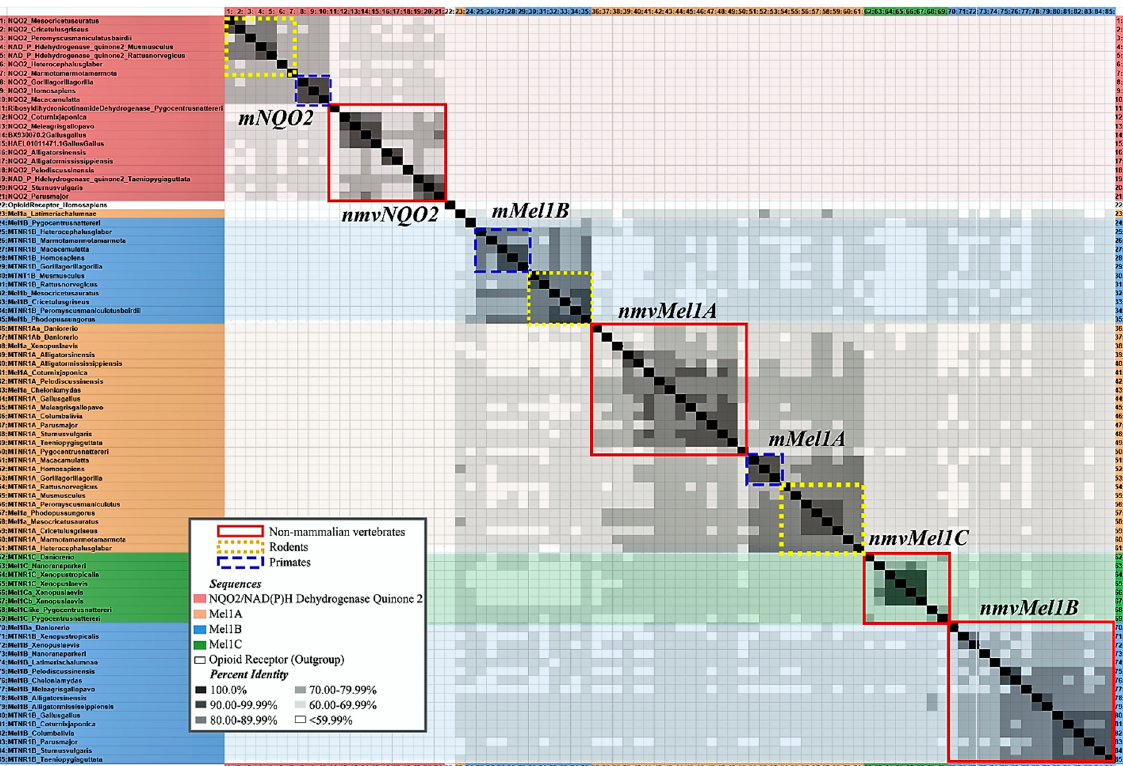
Figure 3. Percent Identity Matrix of Melatonin Membrane Receptor Subtypes and Quinone Reductase 2. Analysis run by Clustal Omega 2.1 using NCBI GenBank. Red solid lines outline non-mammalian vertebrates ( nmv ), yellow dotted lines outline rodents, and blue dashed lines outline primates. Shades of grey indicate ranges of percent identity, black 100% and progressively lighter shades of grey down to 60%. Values <60% identity are white. Non-mammalian vertebrate ( nmv ) Mel1B sequences (lower right corner) do not have significant similarity with mammalian ( m ) Mel1B sequences (mid-upper left), suggesting that these are phylogenetically distinct melatonin membrane receptors. There is higher similarity within Mel1A receptor subtypes across vertebrates (mid-lower right). The quinone family in the upper-left [named NAD(P)H dehydrogenase quinone 2, ribosyldihydronicotinamide dehydrogenase, or NQO2] shows no significant similarity with other membrane melatonin receptor subtypes with percent identity across vertebrates and melatonin receptor subtypes <60%, supporting the position that QR2/NQO2 is not a putative MT3 membrane subtype receptor.